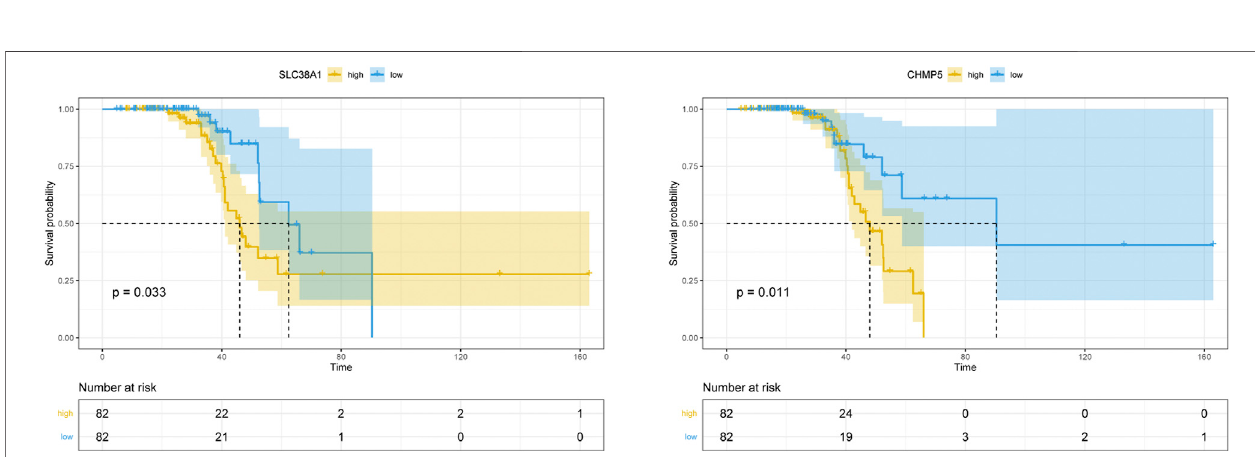
FIGURE 8 | Kaplan – Meier survival curve of the 18 overlapping FRGs in blood data. CHMP5 and SLC38A1 revealed signi fi cant survival differences ( p < 0.05).